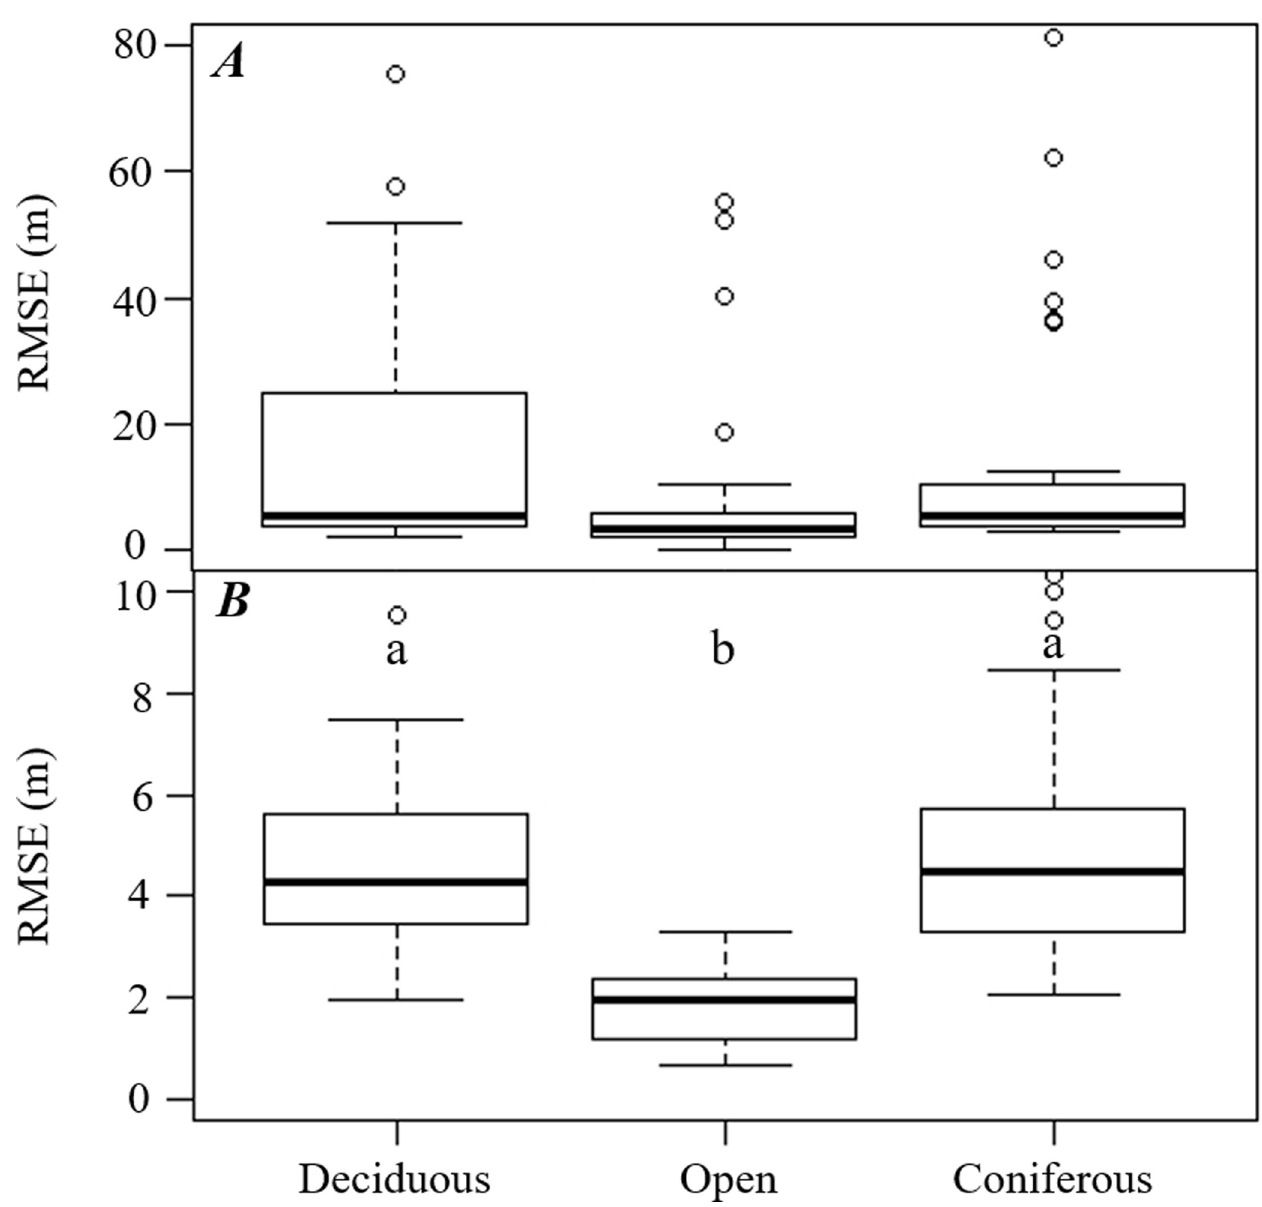
Fig 4. Boxplots describing horizontal positional accuracy (RMSE) by equipment type (GPS watch: A ; Mapping-grade GNSS receiver: B ) and cover type. Different letters indicate significant differences (Dunn’s Test at p-value <